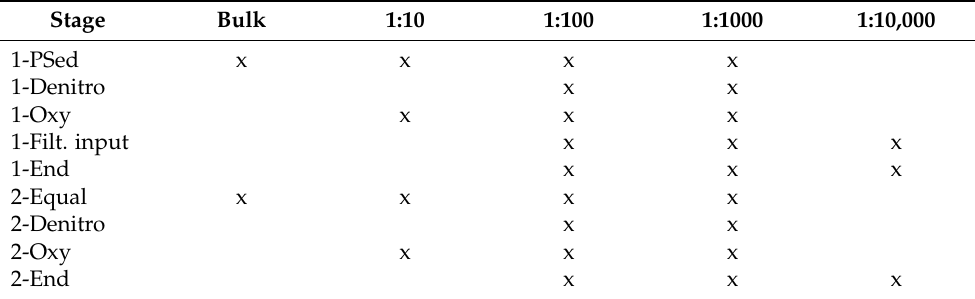
Table 2. Dilution scheme for wastewater and sludge